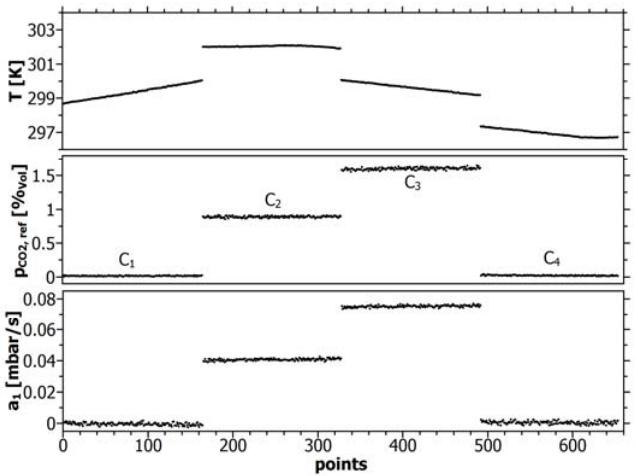
Figure 3. CO and temperature T during calibration.